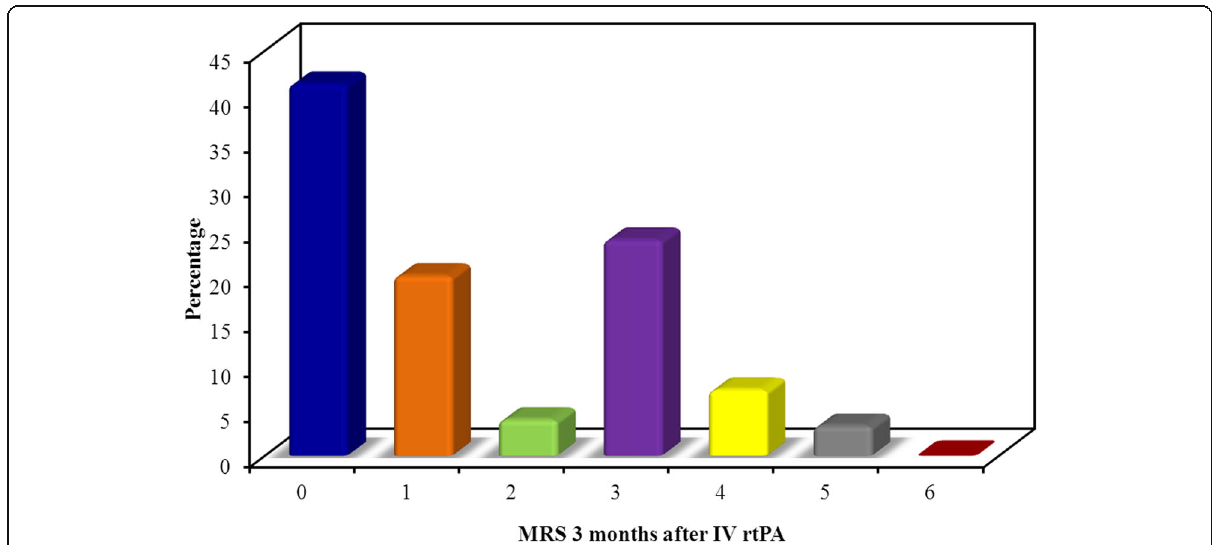
Fig. 1 mRS score 3 months after IV rtPA among the patients ( n = 150).